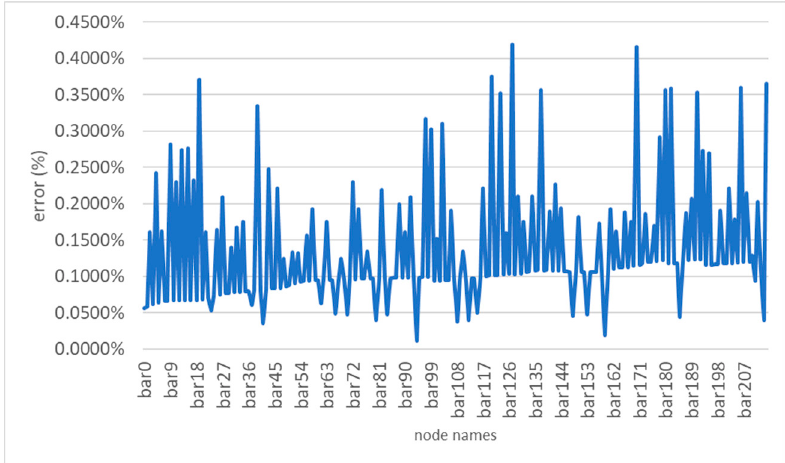
Figure 13. Voltage magnitude error produced by the state estimator.